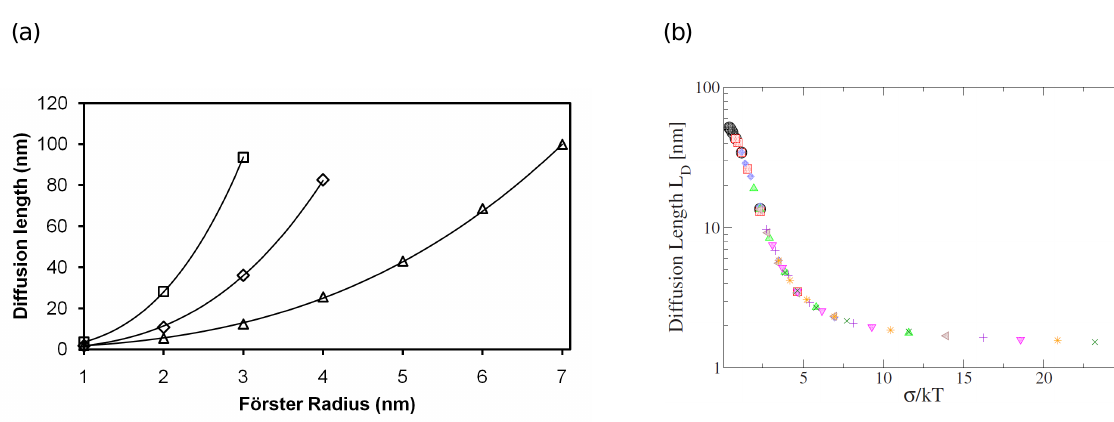
) as a function of σ . Reprinted D